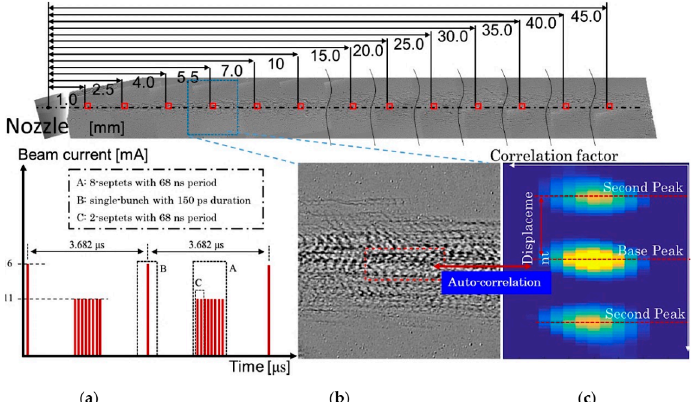
Figure 2. Spray velocity calculation based on a double-exposed image of X-ray imaging. ( a ) X-ray bunch mode; ( b ) double-exposed image ( c ) auto-correlation calculation to derive spray velocity.